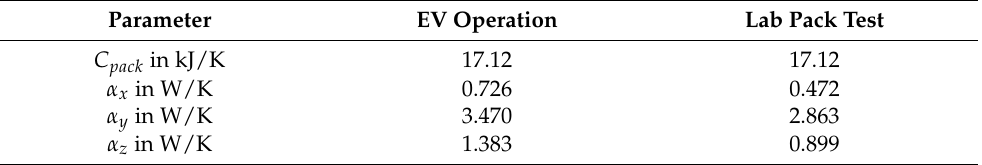
Table 7. Values for heat capacity of the pack C pack and the convective heat transfer coefficients α for each spatial direction ( x,y,z ). Parameters of thermal battery pack model shown in Figure